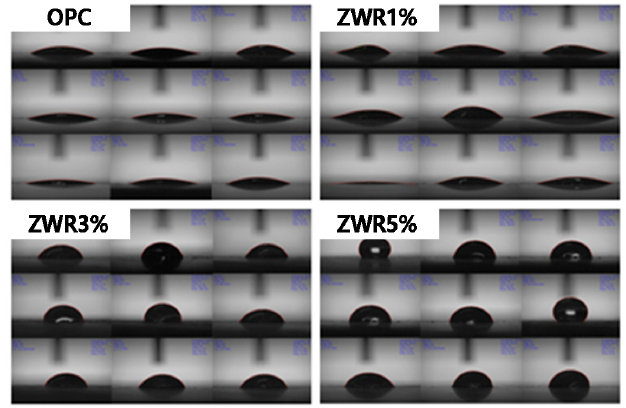
Figure 11. Result of contact angle test 91